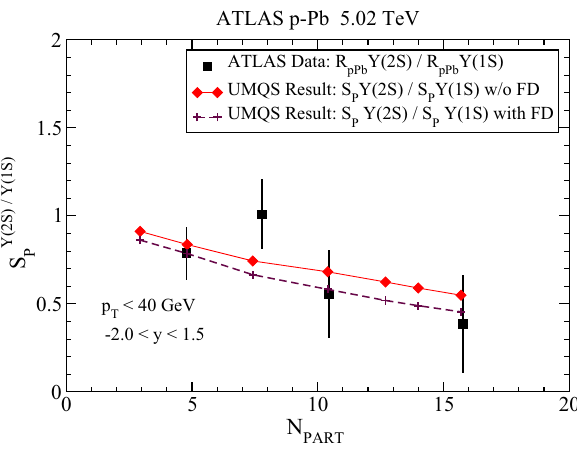
Fig. 18 The centrality variation of our calculated yield ratio of ϒ( 2 S ) to ϒ( 1 S ) is compared with the measured double ratio as a function of centrality in p–Pb collisions obtained from ATLAS experiment at √ s NN = 5 . 02 TeV